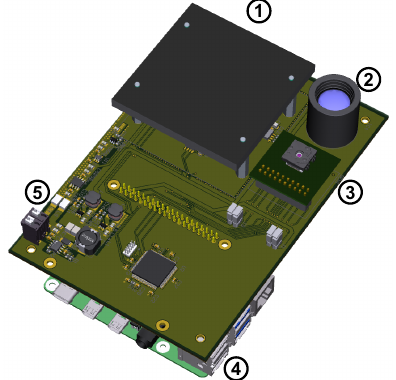
Figure 1. ( a ) Schematic mounting concept of sensor showing alignment and field of view, ( b ) close up of mounted sensor system consisting of (1) an NM500 evaluation USB stick, (2) an 80 × 64 sensor, (3) a 160 × 120 sensor, (4) a Raspberry Pi4, and (5) a battery pack. ( c ) Full view of mounted sensor system.